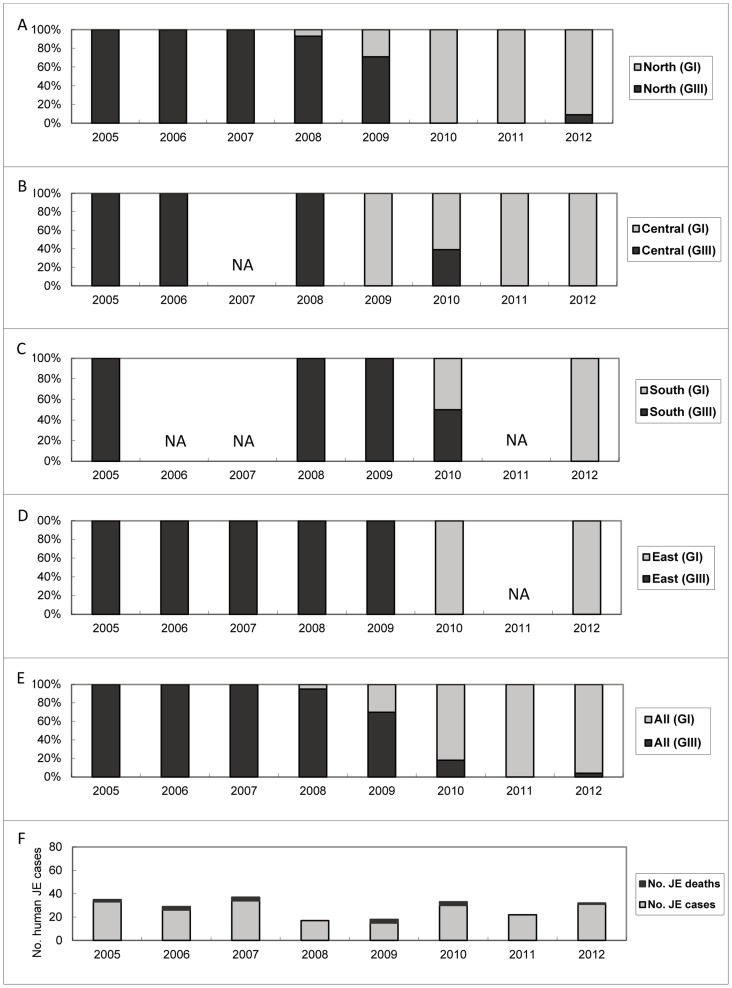
Proportions of genotype distributions of Japanese encephalitis virus strains and annual numbers of Japanese encephalitis cases in Taiwan between 2005 and 2012.The proportions of genotype distributions in northern (A), central (B), southern (C), eastern (D), all (E) of Taiwan, and the annual numbers of confirmed and death cases of individuals with Japanese encephalitis (F). NA = not available.